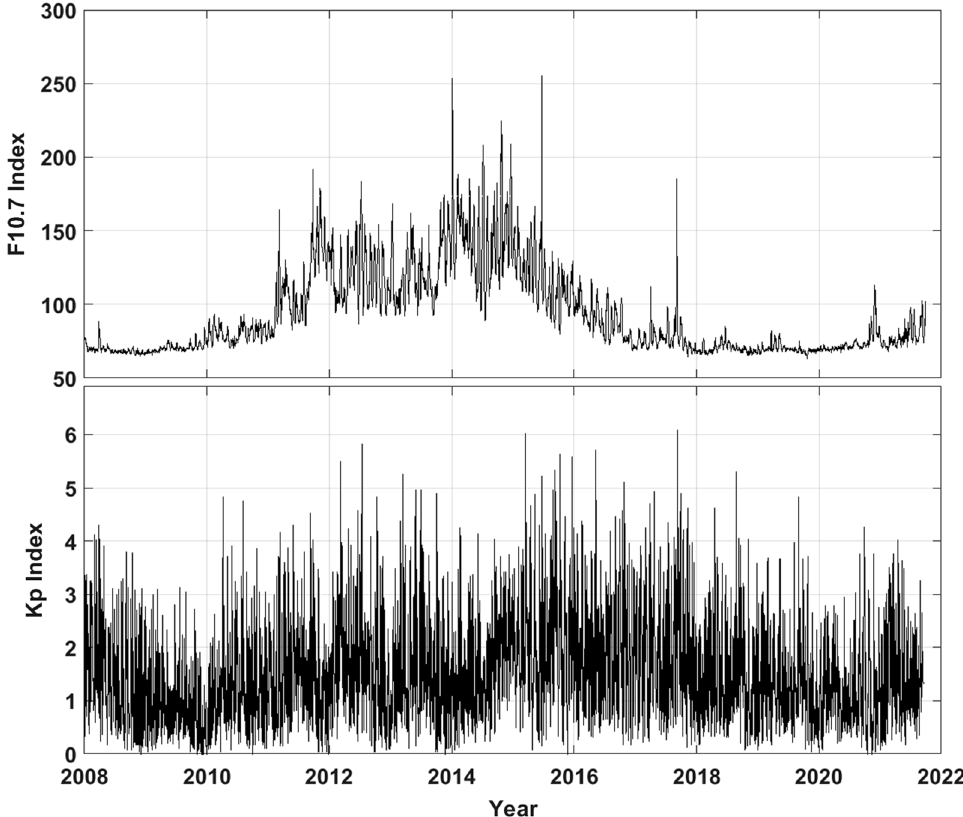
Fig. 1 The solar radio flux F10.7 and Kp index variations during